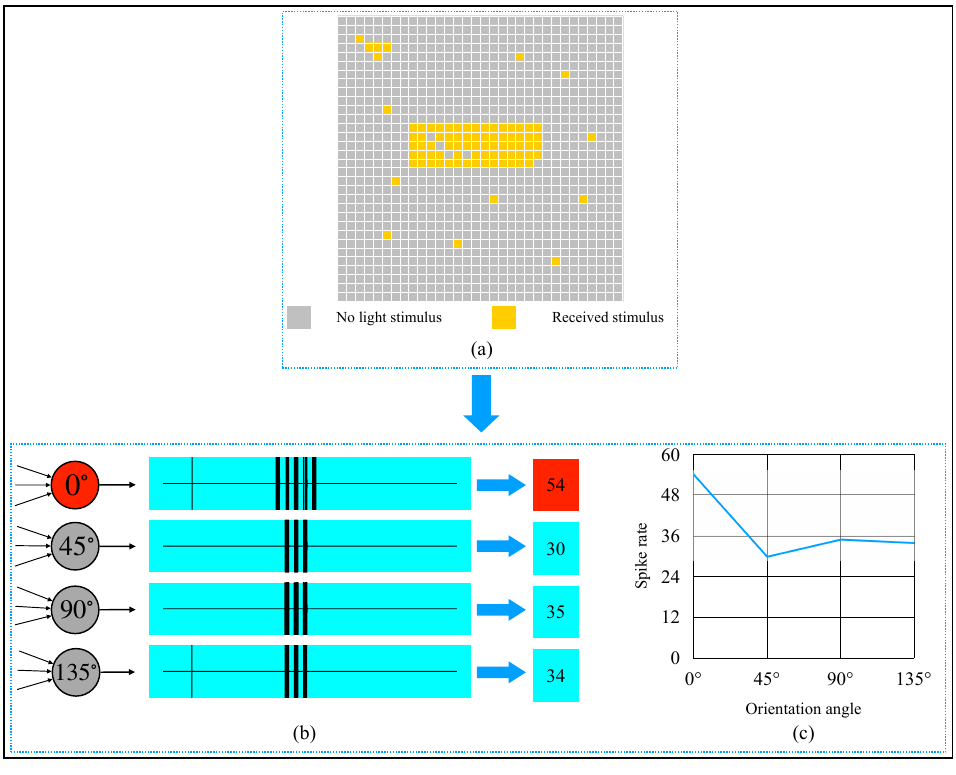
Figure 19. Computer simulation results of orientation detection on an object with 0 ◦ orientation angle. ( a ) Object and image noise ( b ) Spike records. ( c ) Spike rate curve of four types of complex cells.